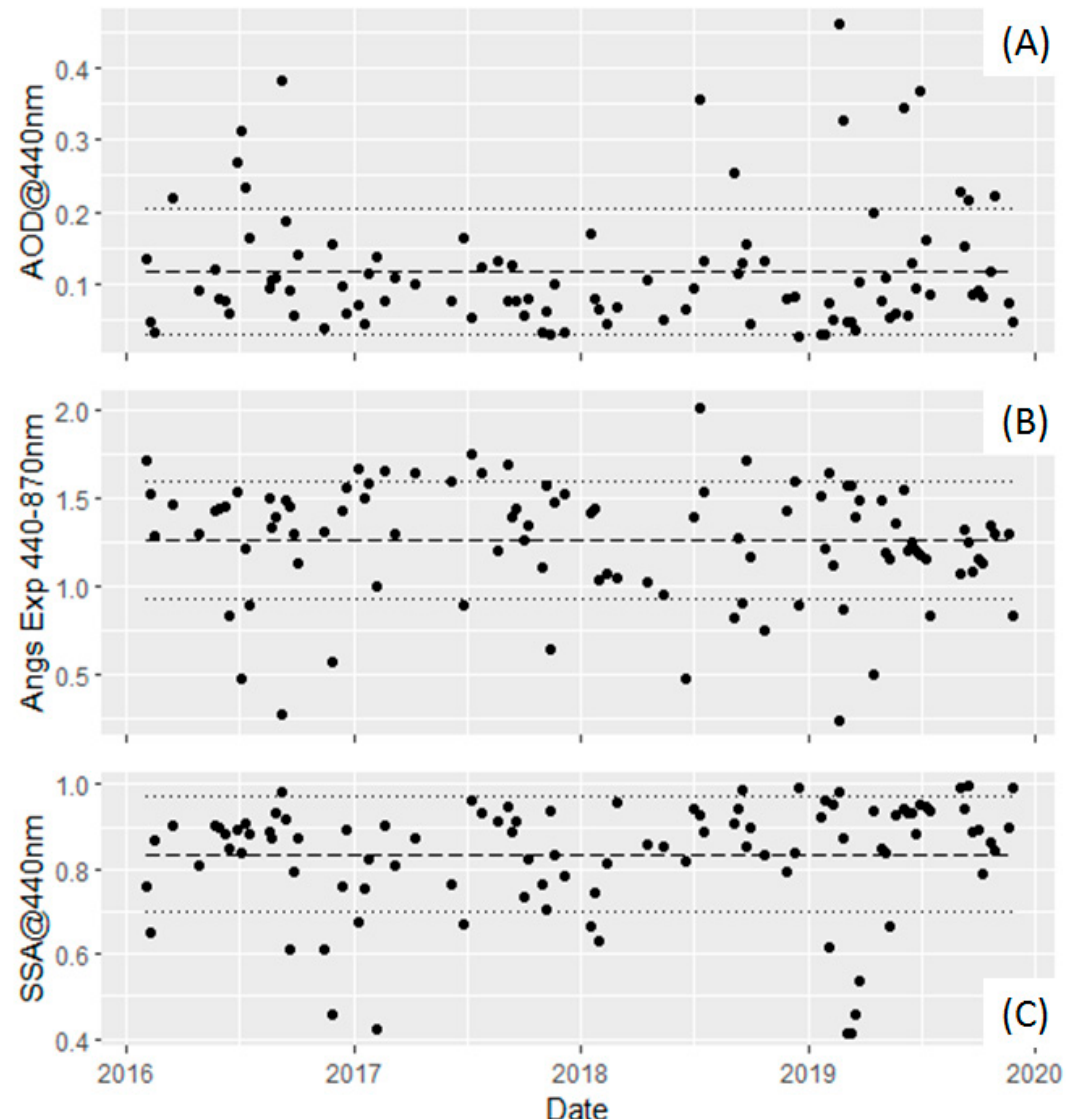
Figure 3. Temporal evolution of those AERONET measurements in coincidence with EARLINET profiles (within 1 h) of ( A ) AOD at 440 nm, ( B ) Angstrom Exponent between 440 and 870 nm, and ( C ) single scattering albedo for each measurement time of the study (2016–2019).